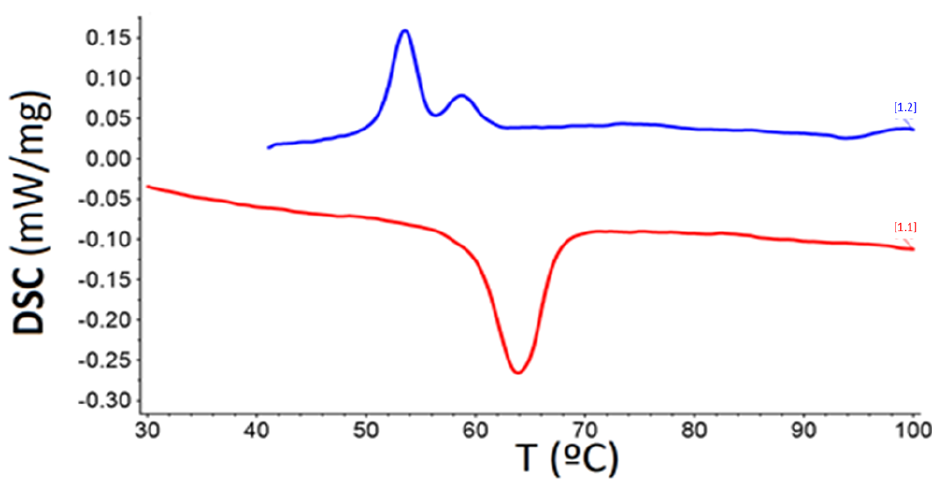
Figure 1. DSC data (blue line—cooling, red line—heating) for rapidly quenched Ti 2 NiCu ribbon annealed for 2 h at a temperature of 450 °C.